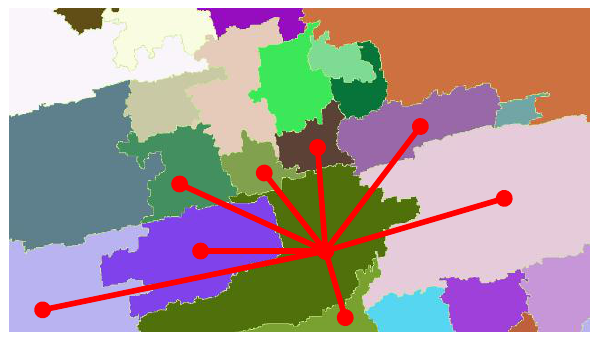
Figure 9. A representation of the nodes (red dots) and connections (red lines) derived from watershed segments